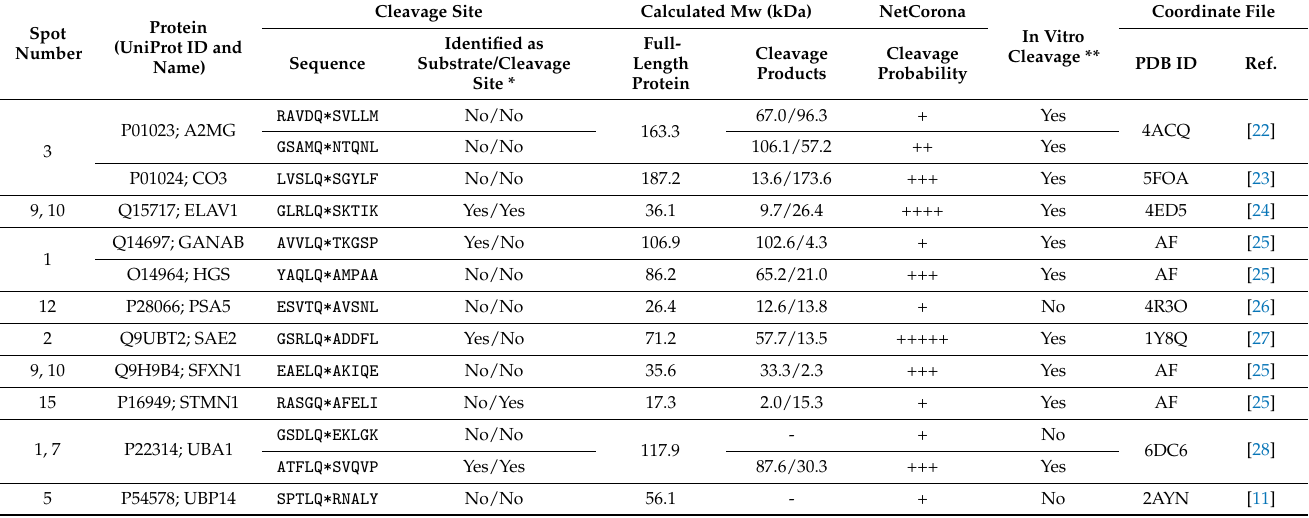
Table 2. Summary tables of predicted SARS-CoV-2 Mpro cleavage sites. * The substrates and cleavage sites—studied in this work—were compared to those identified previously by Koudelka et al. [19]. P1 Gln residues are bold. ** To prove that the candidate sites are susceptible to proteolysis, cleavage reactions were performed using His 6 -MBP-mEYFP recombinant proteins as substrates of SARS-CoV-2 Mpro. Representative cleavage reactions are shown in Figure 3. If structural coordinate was not available in Protein Data Bank, the structure predicted by AlphaFold was used